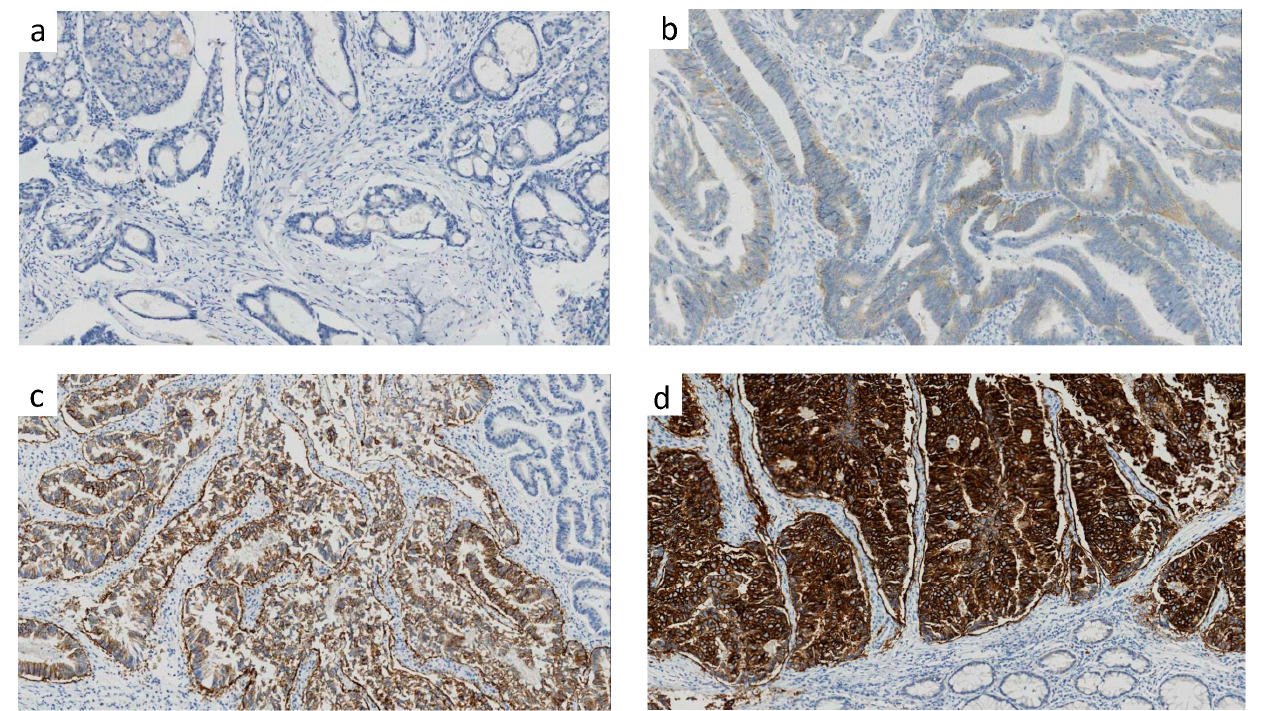
Figure 2. Representative images of HER2 proteins. Representative images of HER2 IHC score of 0 ( a ), 1 ( b ), 2 ( c ), 3 ( d ); 10 × ; IHC, immunohistochemistry.